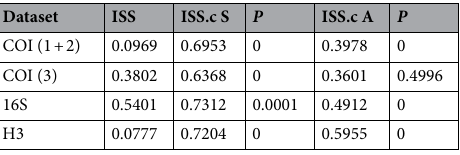
Table 1. Results of the substitution saturation tests performed in